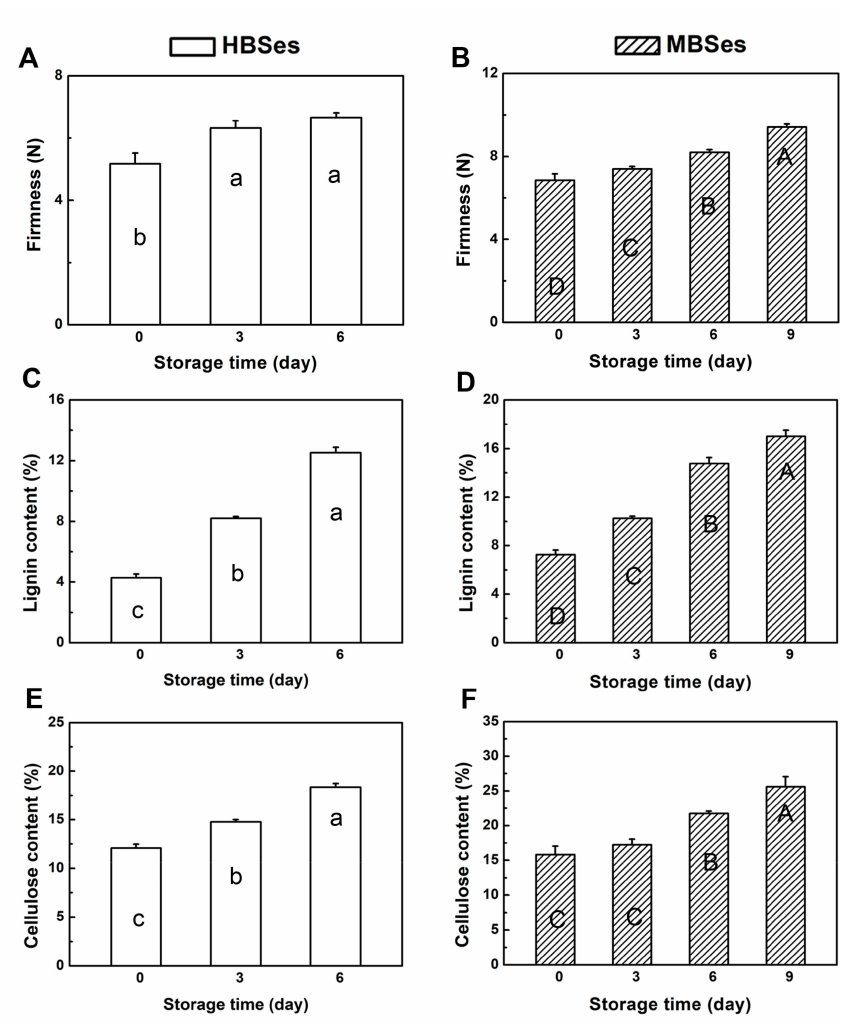
Figure 2. Changes in the firmness, lignin, and cellulose contents of two varieties of bamboo shoots at room temperature. ( A ) Changes in the firmness in high bamboo shoots (HBSes). ( B ) Changes in the firmness in moso bamboo shoots (MBSes). ( C ) Changes in the lignin contents in HBSes. ( D ) Changes in the lignin contents in MBSes. ( E ) Changes in the cellulose contents in HBSes. ( F ) Changes in the cellulose contents in MBSes. Error bars indicate the standard error. Different letters indicate significant differences ( p < 0.05) among various storage times in HBSes (lowercase letters) and MBSes (uppercase